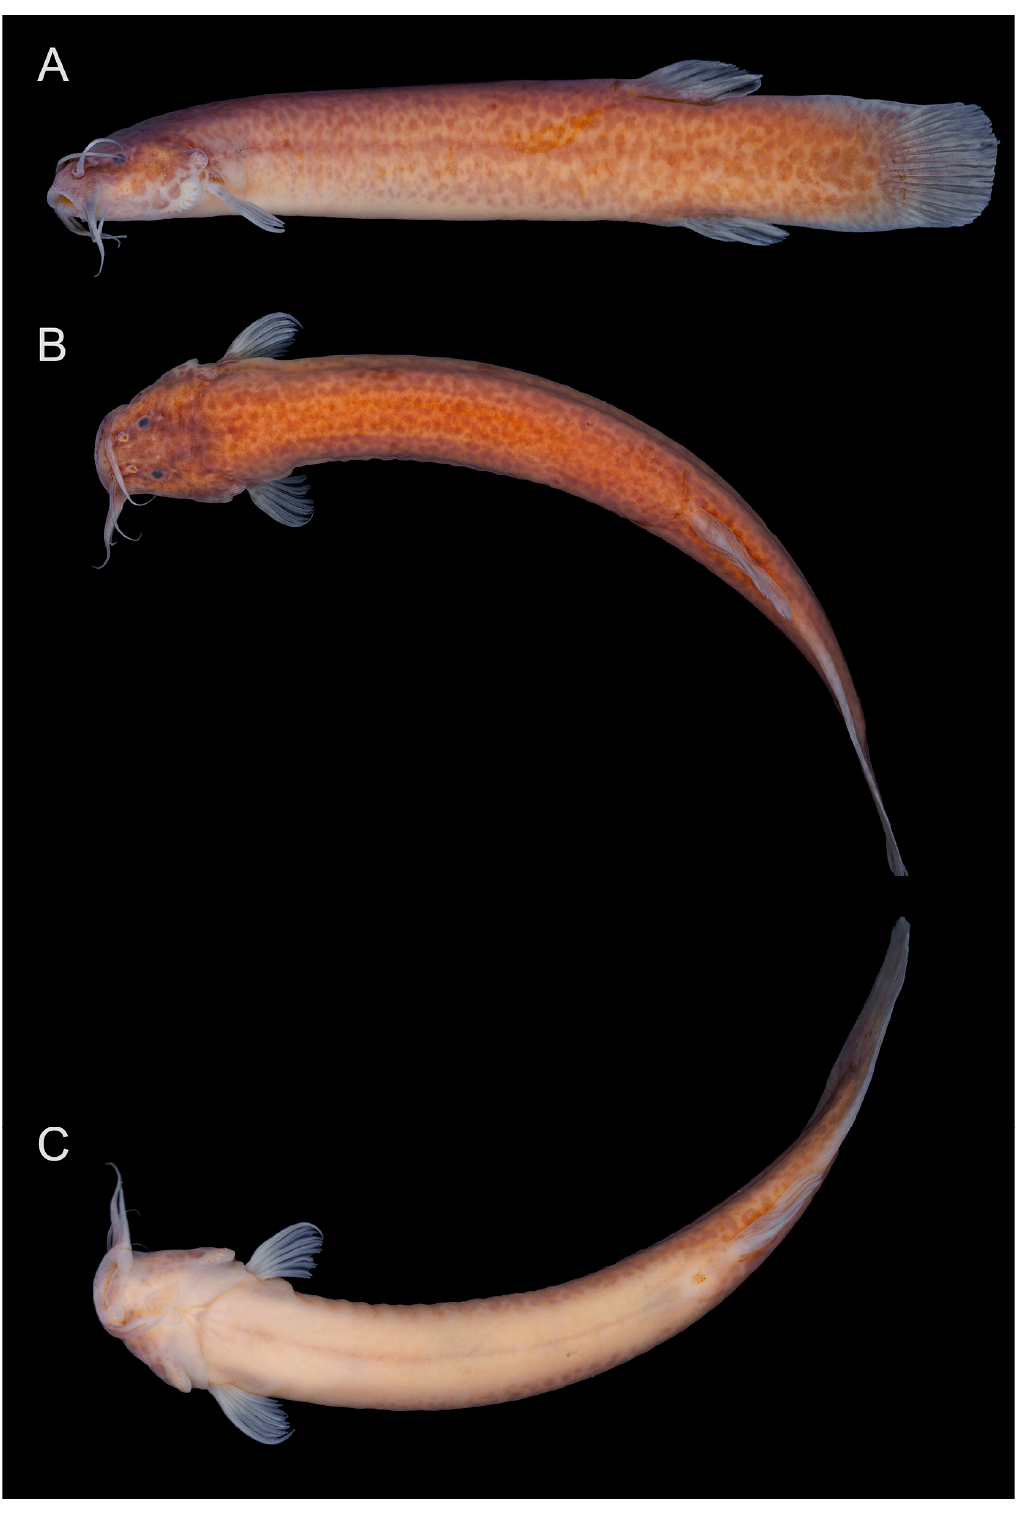
Figure 8. Trichomycterus ( Cryptocambeva ) listruroides Costa, Katz & Azevedo-Santos sp. nov. Holotype, UFRJ 11845, Capitólio, 55.1 mm SL: ( A ) lateral, ( B ) dorsal, and ( C ) ventral views. The dorsal and anal fi ns are rounded, the dorsal fi n is slender, and the longest ray is shorter than the anal- fi n base length. Total dorsal- fi n rays are 11 (ii + II + 7), and total anal- fi n rays are 9 (ii + II + 5). The anal- fi n origin is at vertical through the middle portion of the dorsal- fi n base, or slightly anterior to it, and at vertical through the base of fi fth segmented dorsal- fi n ray. The dorsal- fi n origin is at vertical through the centrum of the 24th vertebra,